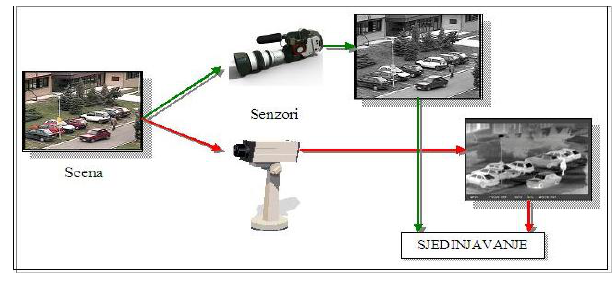
kombinuju u jednu sliku. Ovakav pristup prevazilazi probleme o kojima je govoreno ranije. Dok je televizijska kamera pogodna za rad u dnevnim uslovima, termovizijska kamera se koristi u uslovima slabe osvetljenosti